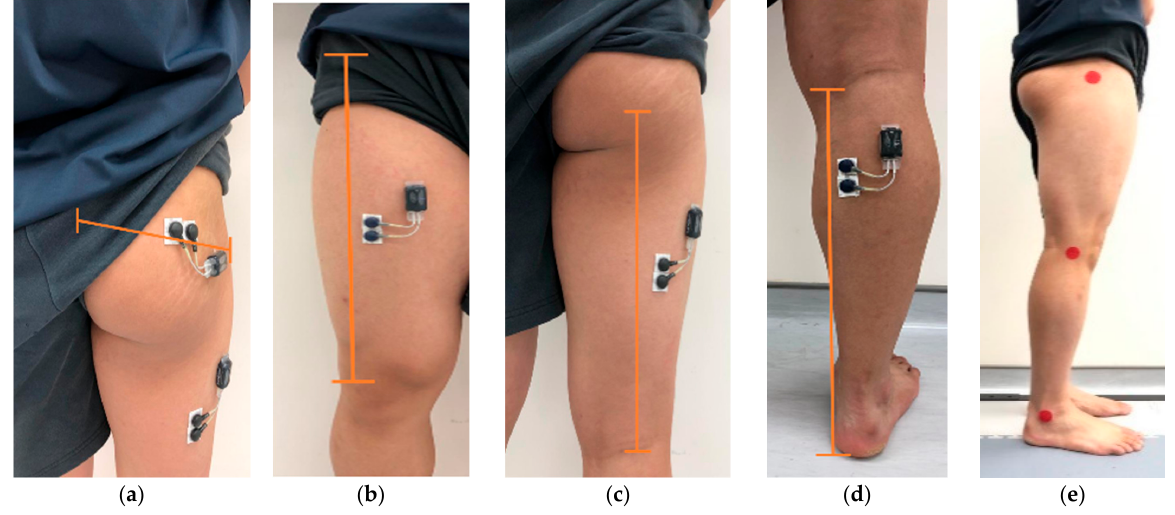
Figure 2. Location of the ( a ) gluteus maximus (GM) electrode placement, ( b ) rectus femoris (RF) electrode placement, ( c ) biceps femoris (BF) electrode placement, ( d ) gastrocnemius (GA) electrode placement, ( e ) three bony landmarks with markers attached.